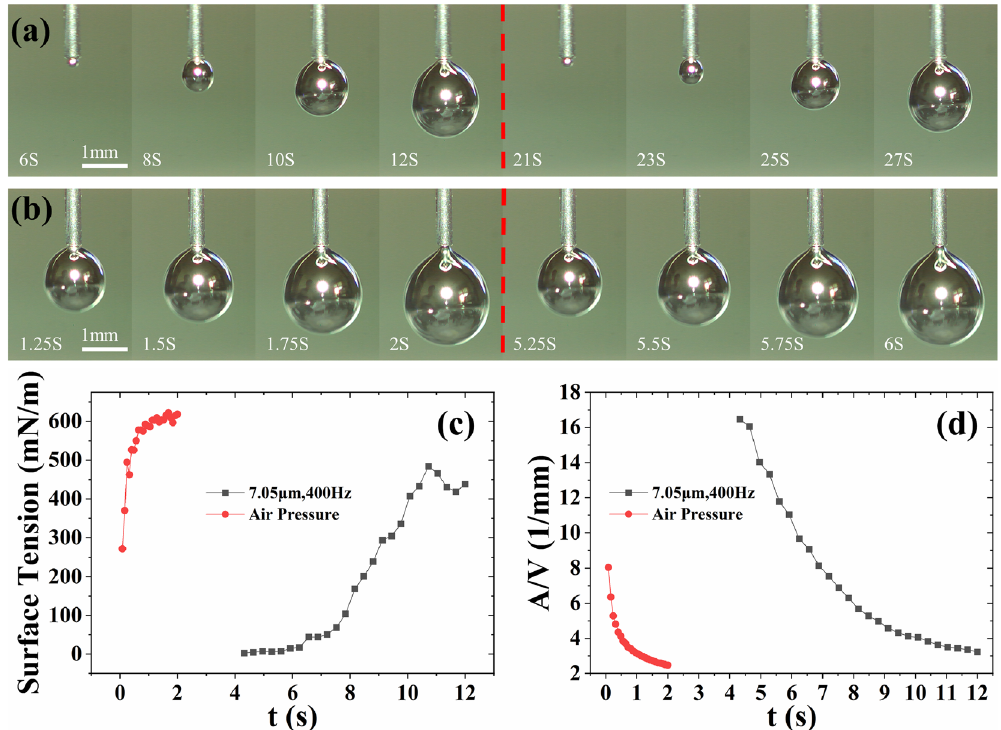
Figure 6. Comparison of micro-vibration and pneumatic. ( a ) The EGaIn extrusion process under micro- vibration. ( b ) The EGaIn extrusion process under pneumatic. ( c ) Surface tension of droplets extrusion under